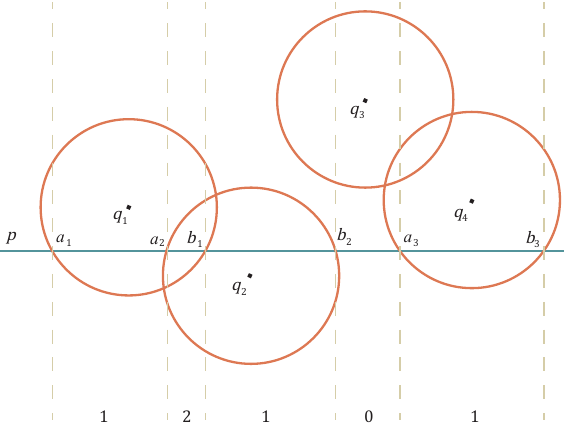
Fig. 3 Predicting 1-dimensional missing